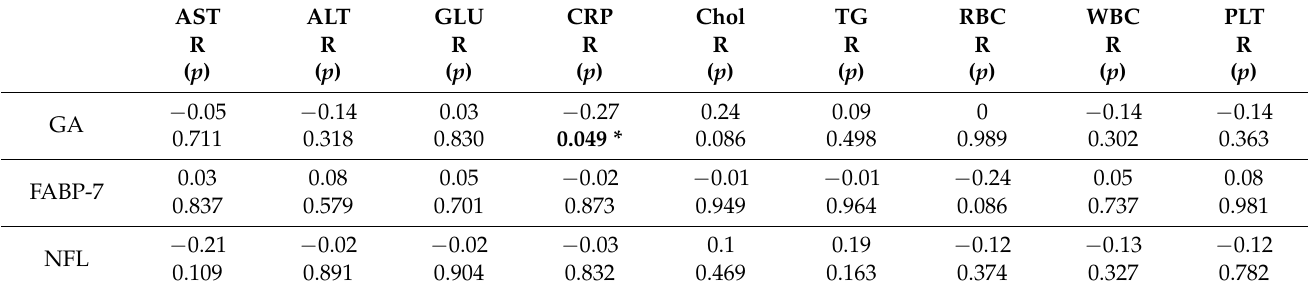
Table 3. Correlations between FABP-7, GA, NFL and laboratory parameters.